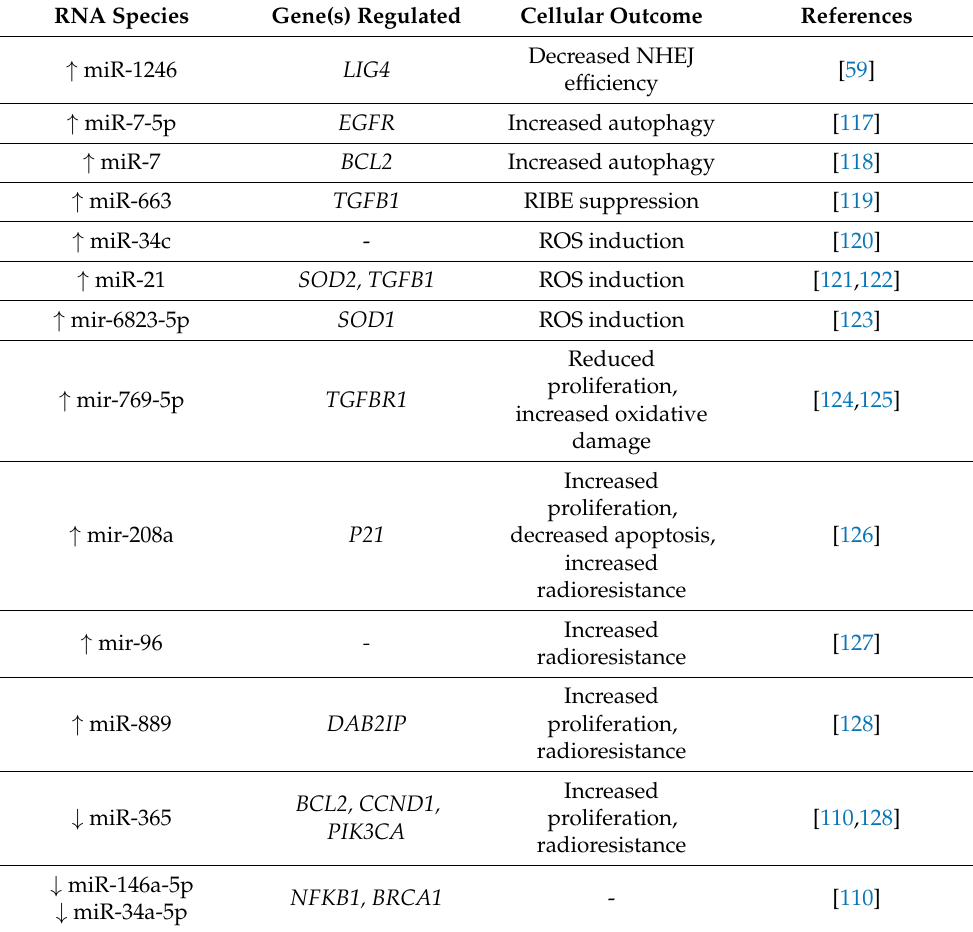
Table 3. RNA species with dysregulated expression in exosomes or bystander cells upon irradiation and their contribution to